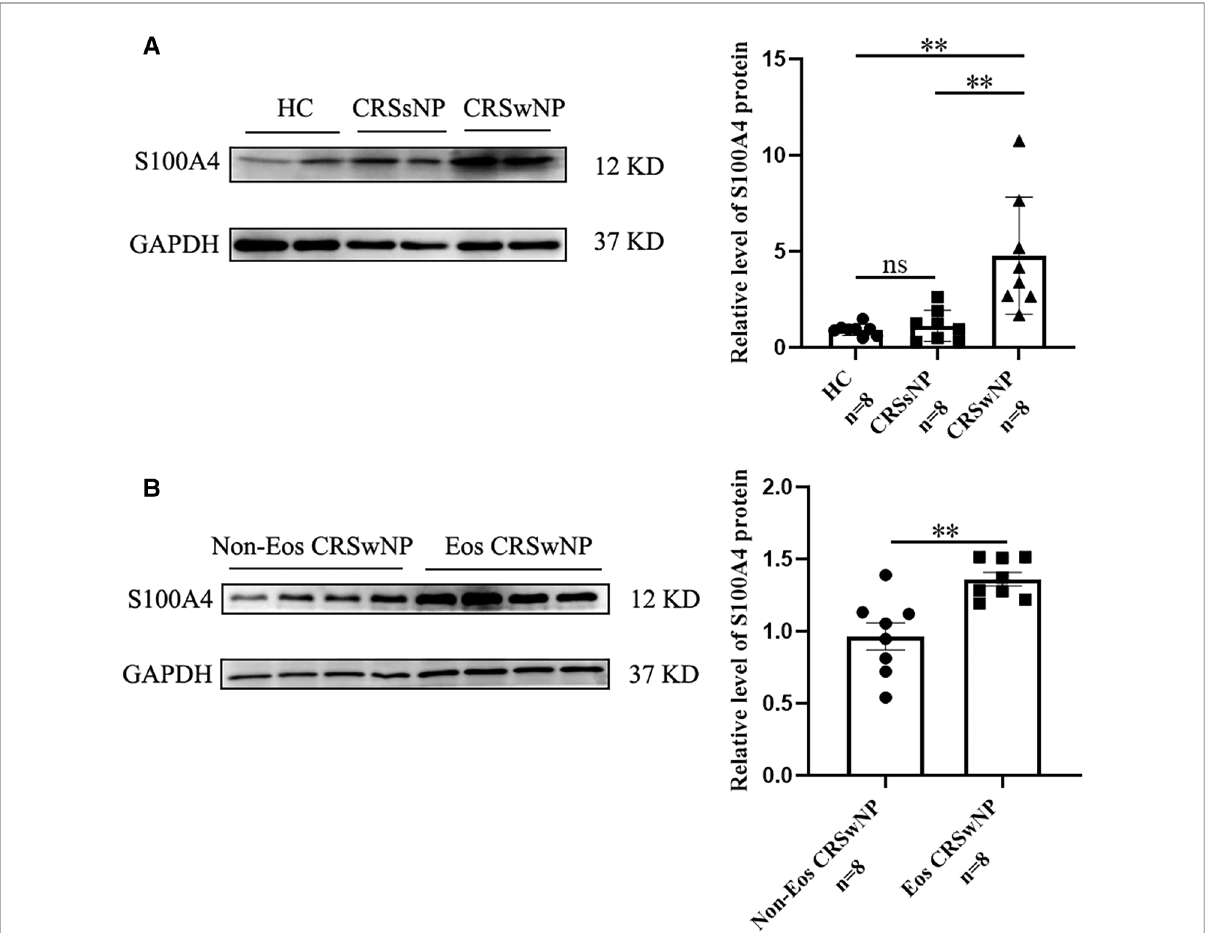
FIGURE 5 The S100A4 protein expression in the tissue based on western blotting. ( A ) Western blotting images of S100A4 among three groups, and the S100A4 protein relative levels were signi fi cantly increased in the CRSwNP group compared to the HC group and the CRSsNP group. ( B ) Western blotting images of S100A4 between the EOS CRSwNP group and non-EOS CRSwNP groups and the S100A4 protein relative levels were signi fi cantly higher in the EOS CRSwNP group than non-EOS CRSwNP groups. ** p <0.01, ns, no signi fi cance. Abbreviations: CRSwNP, chronic rhinosinusitis with nasal polyps; HC, healthy control; CRSsNP, chronic rhinosinusitis without nasal polyps; EOS CRSwNP, eosinophilic chronic rhinosinusitis with nasal